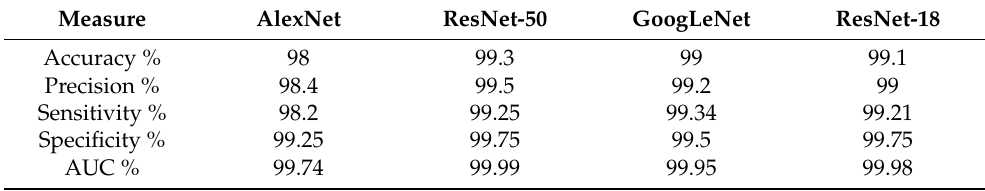
Table 4. The results of the CNN models used on the microscopic blood sample dataset.